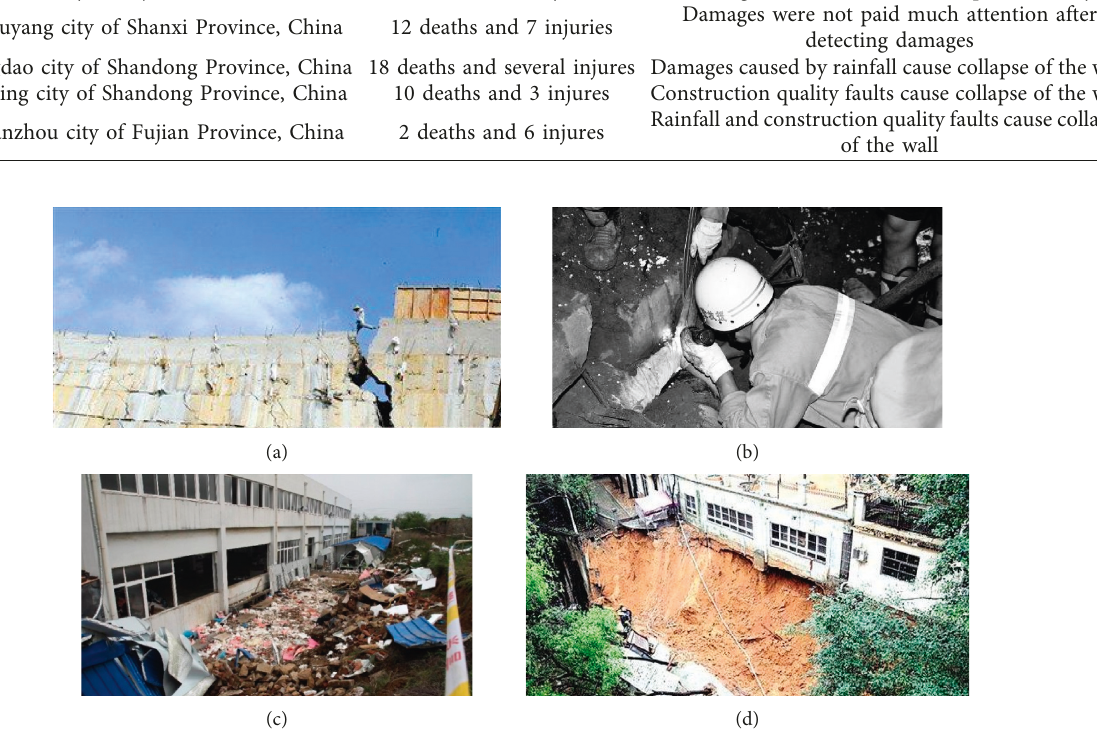
Figure 1: Accidents of retaining wall collapse (the photos above from the internet). (a) Retaining wall in Shenwu city. (b) Retaining wall